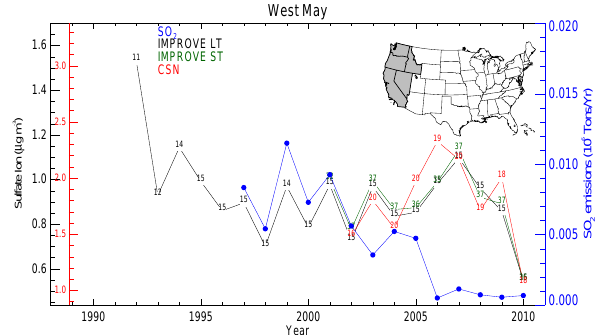
Fig. 8. May monthly and regional mean particulate sulfate ion con- centrations (µg m − 3 ) for the West region (see gray states on inset map) from long-term (LT) and short-term (ST) IMPROVE sites (left black axis) and CSN sites (left red axis), and power plant SO 2 emis- sions (million t yr − 1 ) (right blue axis). The number of complete sites with valid data available for a given year is used as the plot symbol for each time series.